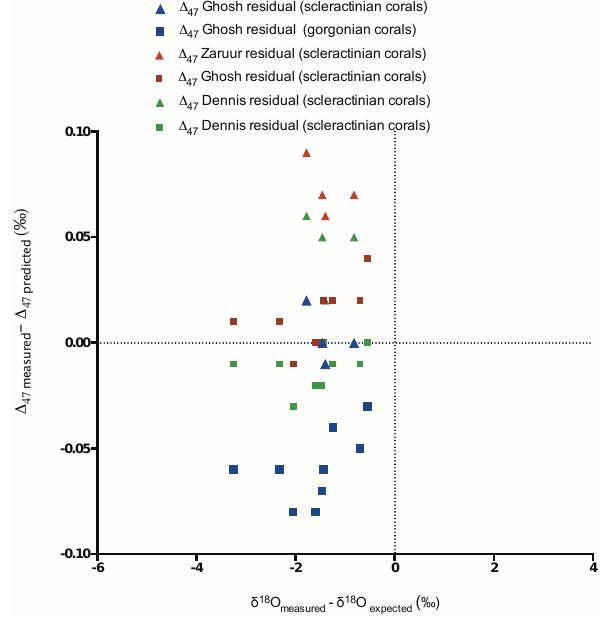
Figure 7. (cid:49) 47 residuals are calculated from average measured (cid:49) 47 values for each coral relative to the inorganic calibrations of Ghosh et al. (2006), Zaarur et al. (2013), and Dennis and Schrag (2010). δ 18 O residuals are calculated from average measured δ 18 O values relative to the calibrations of Kim and O’Neil (1997) and Kim et al. (2007) for calcite and aragonite,